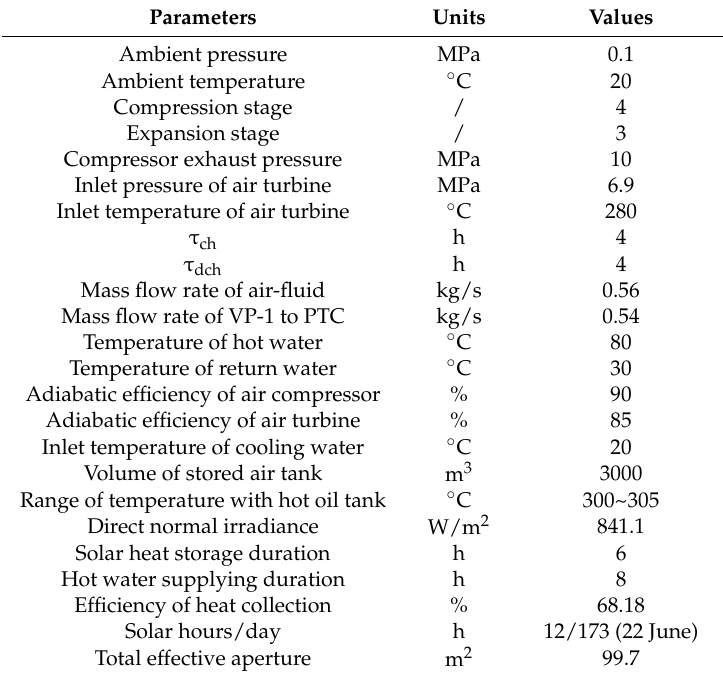
Table 3. Basic design parameters of ST-CAES system.